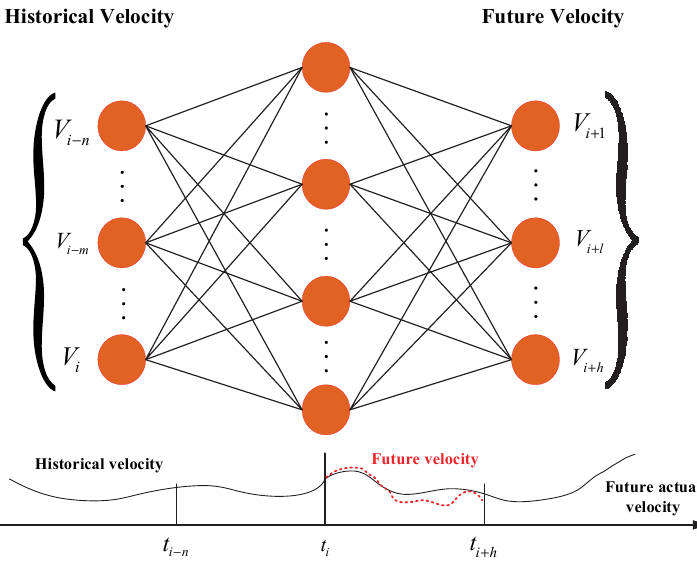
Figure 7. Neural network prediction principle diagram.